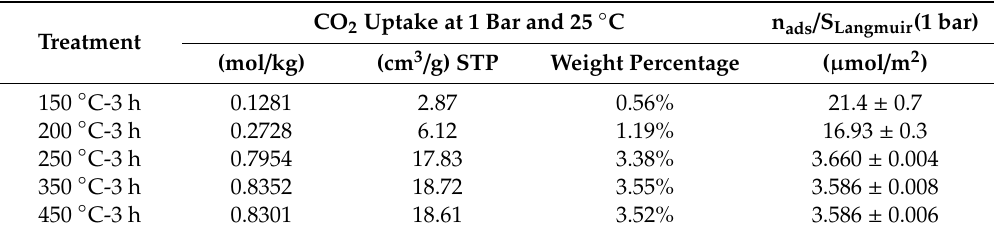
Table 2. Summary of CO 2 uptake measurements at 1 bar and 25 °C.